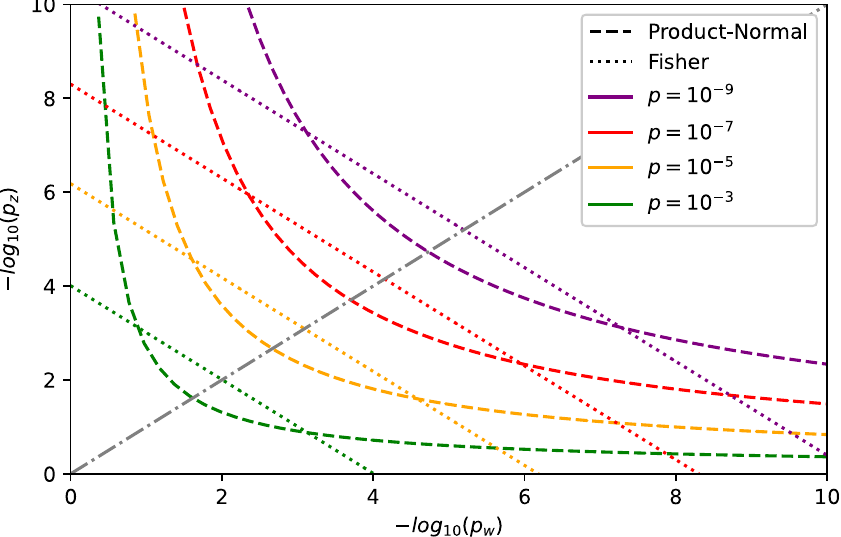
Fig 1. Significance threshold curves in the one element case for the product-normal (dashed) and Fisher’s method (dotted) for various p -values. The diagonal is indicated by a gray dash-dotted line and corresponds to equal − log 10 p -